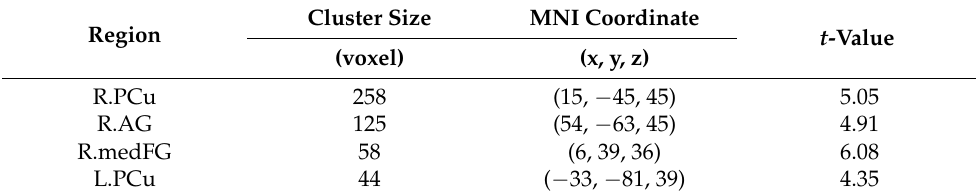
Table 2. Decreased ALFF in VaMCI compared to